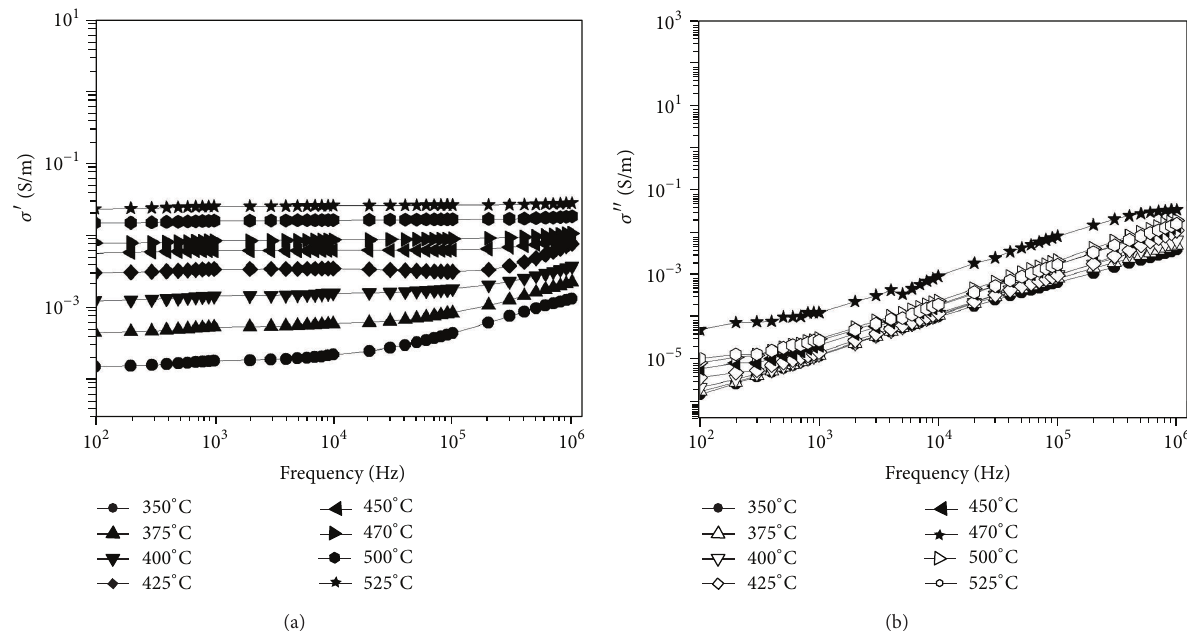
Figure 6: Variation of (a) real and (b) imaginary parts of ac conductivity with frequency at different temperatures for PGT ceramic.